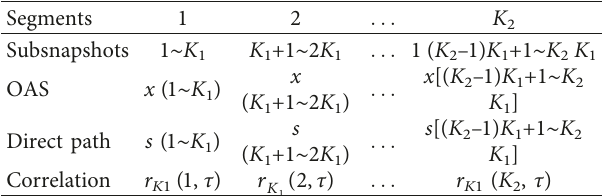
Table 2: Multisnapshots array